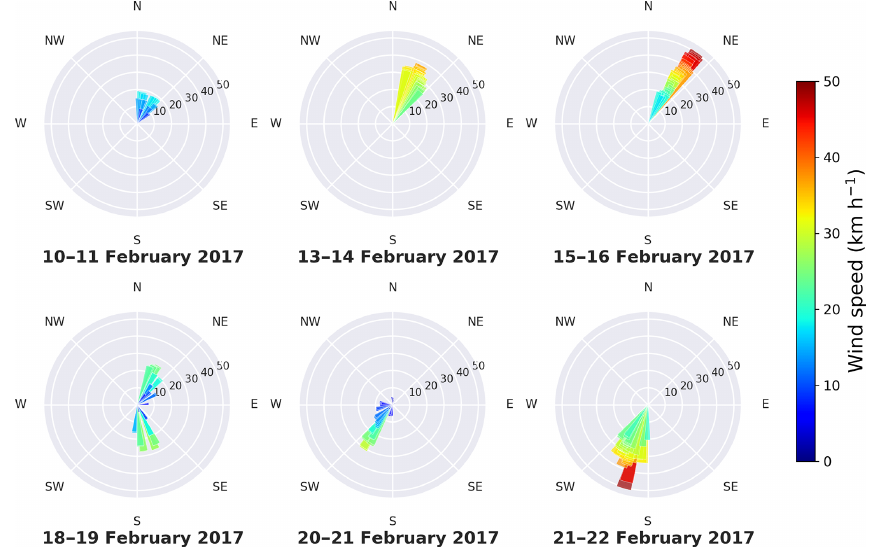
Figure 14. Maps of the 10m level wind (kmh − 1 ), as shown in Fig. 12, but for ice floe no. 38, which was separated from landfast ice and drifted in the polynya downstream from the ice arch formed at the inlet of the Robeson Channel.